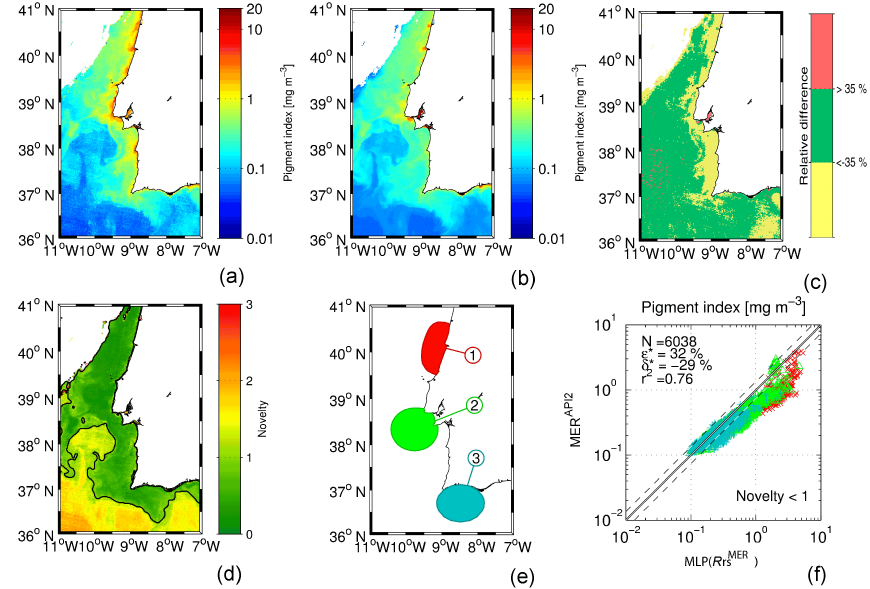
Figure 3. Comparison between the Sagres regional MLP algorithm map and the MERIS pigment index product map for Algal Pigment Index 2 on 25 August 2010, showing (a) the product map of the regional MLP, (b) standard API2 MERIS product map, (c) difference between MER API2 and MLP( R MER rs ), (d) region of applicability of MLP( R MER rs ), (f) results of the application of the regional MLP to the Portuguese coast in the three regions of interest shown in (e) . Please see Sect. 3.2 for a more detailed description of the panels (source: MER_RR_2PRAC20100825_103551_000026292092_00223_44365_0000.N1).